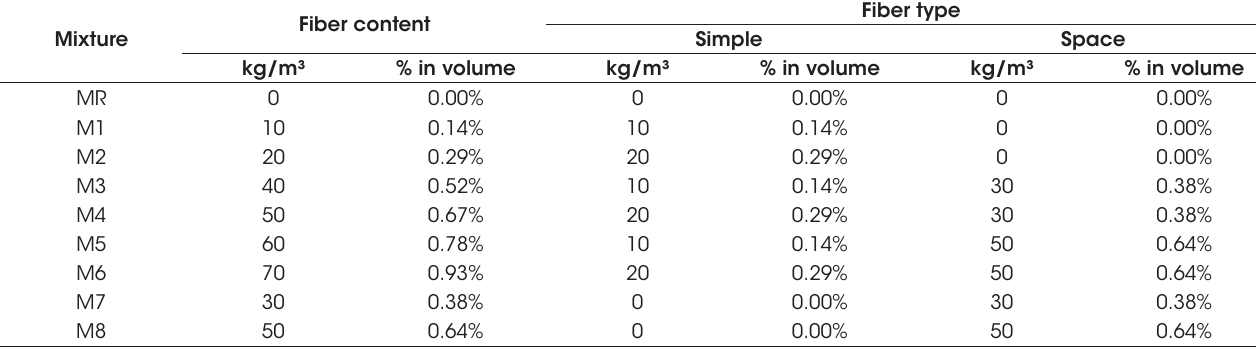
Steel fiber content in the mixture of each composite of this study Fiber Mixture